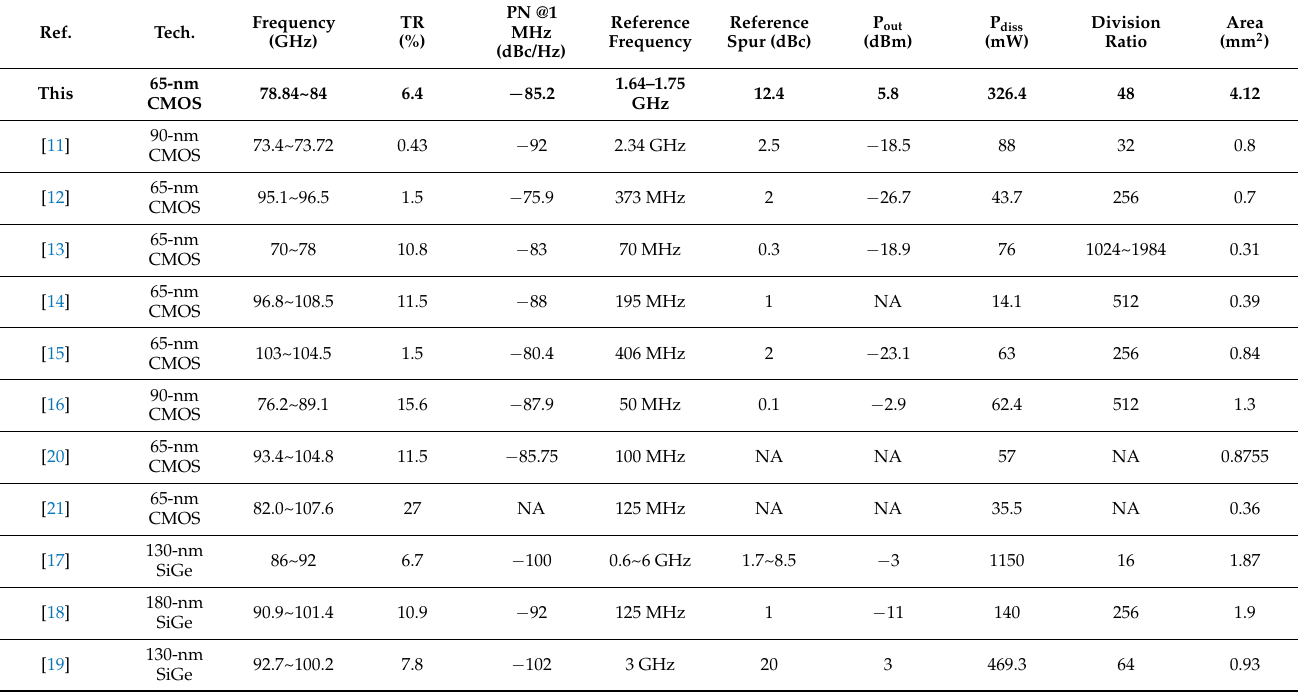
Table 3. Comparison of state-of-the-Art PLLs around